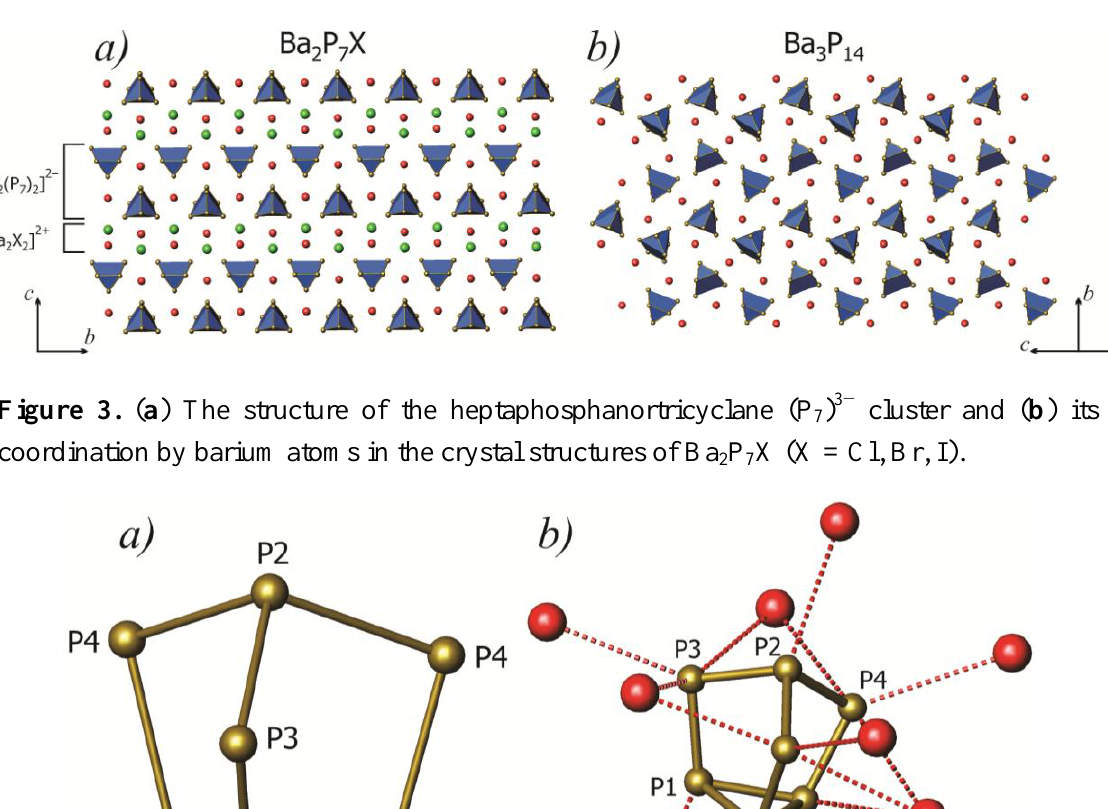
P X and ( b ) Ba P [3]. Barium atoms are shown in red; 2 7 3 14